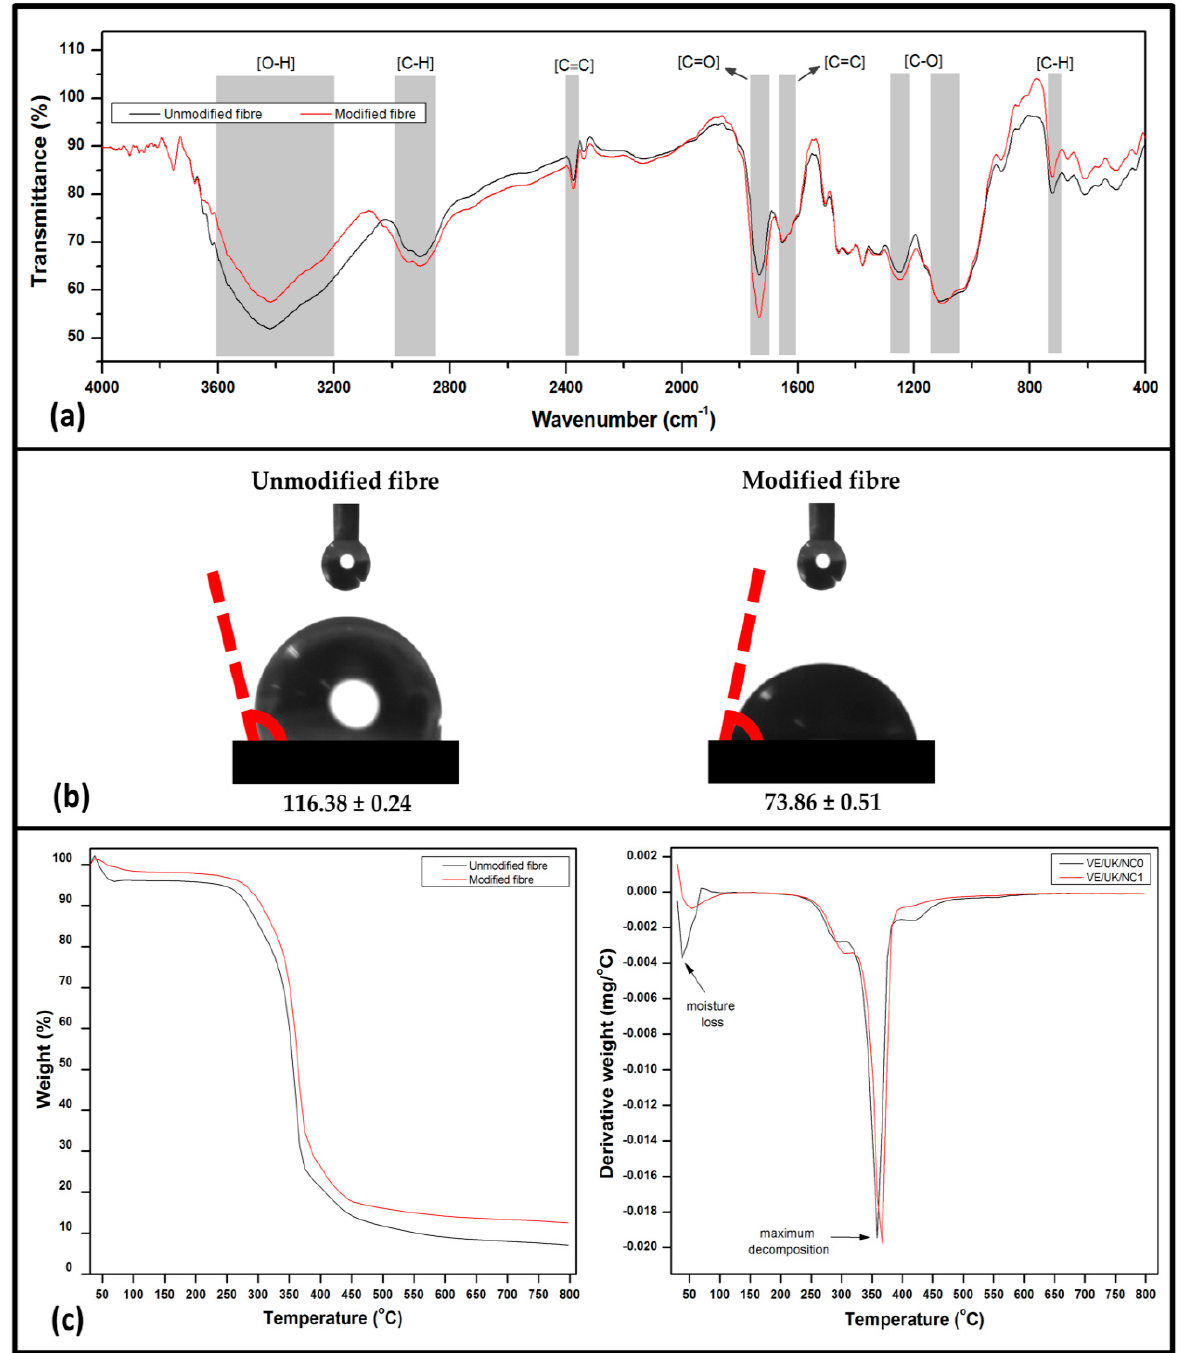
Figure 4. Characterisation of unmodified and modified nonwoven kenaf fibre ( a ) FT-IR, ( b ) contact angle, and ( c ) thermal analysis.